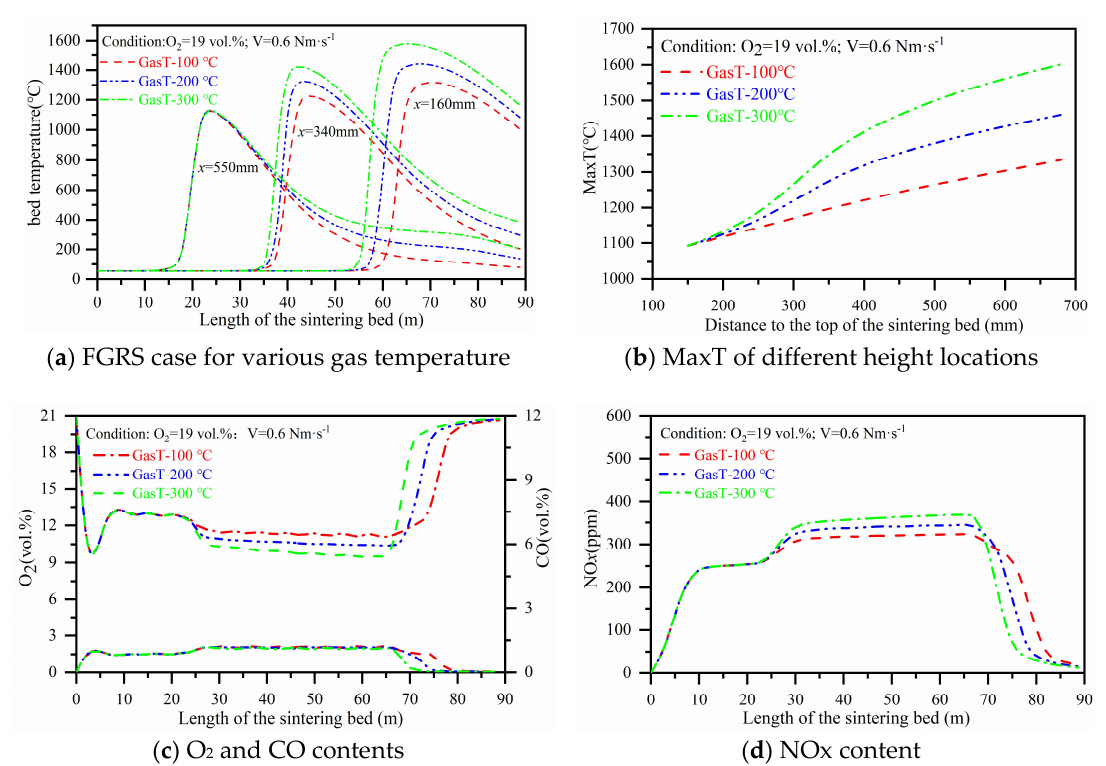
Figure 7. E ff ects of circulating gas temperature on the NOx, CO and O 2 contents in flue gas and layer